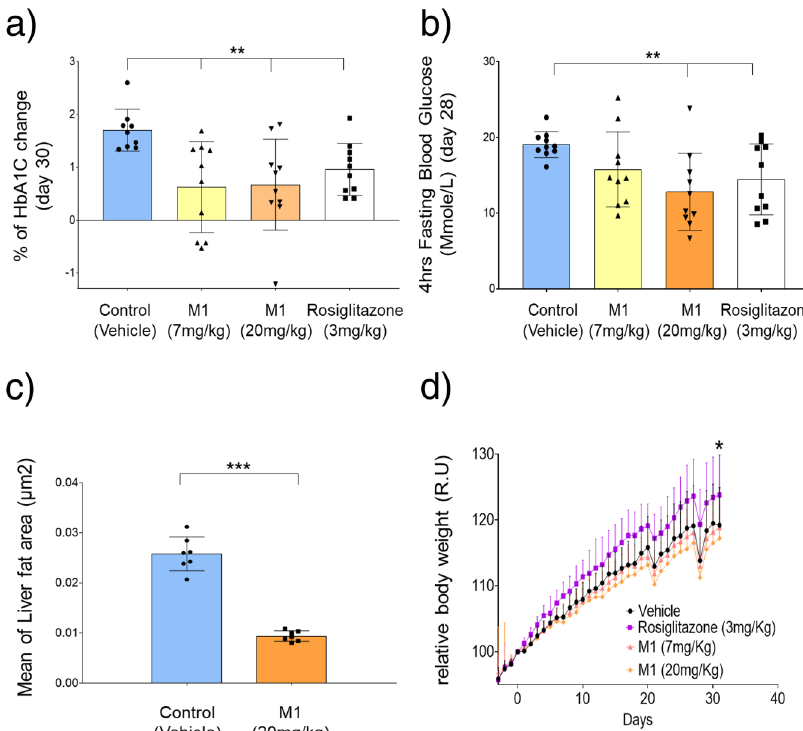
Fig. 4 Oral administration of M1 ameliorates glycemic parameters in db/db mice. a Percentage change (relative to predosed randomization measurements on day-3) in circulating HbA1c after 31 days treatment with 7 mg/kg (yellow) or 20 mg/kg (orange) M1 and 3 mg/kg of rosiglitazone (white). b Blood glucose levels after a 4 h fast following 28 days of treatment with 7 mg/kg (yellow) or 20 mg/kg (orange) M1 and 3 mg/kg (white) of rosiglitazone. c Mean liver fat area following histological assessment after 31 days treatment with 20 mg/kg (orange) d Body weight as a percentage of day 0 following treatment of mice with 7 mg/kg (red circle) and 20 mg/kg (orange diamond) M1, 3 mg/kg rosiglitazone (purple circle) and vehicle control (black circle). *<0.05, **P < 0.01, *** P < 0.0001. n =